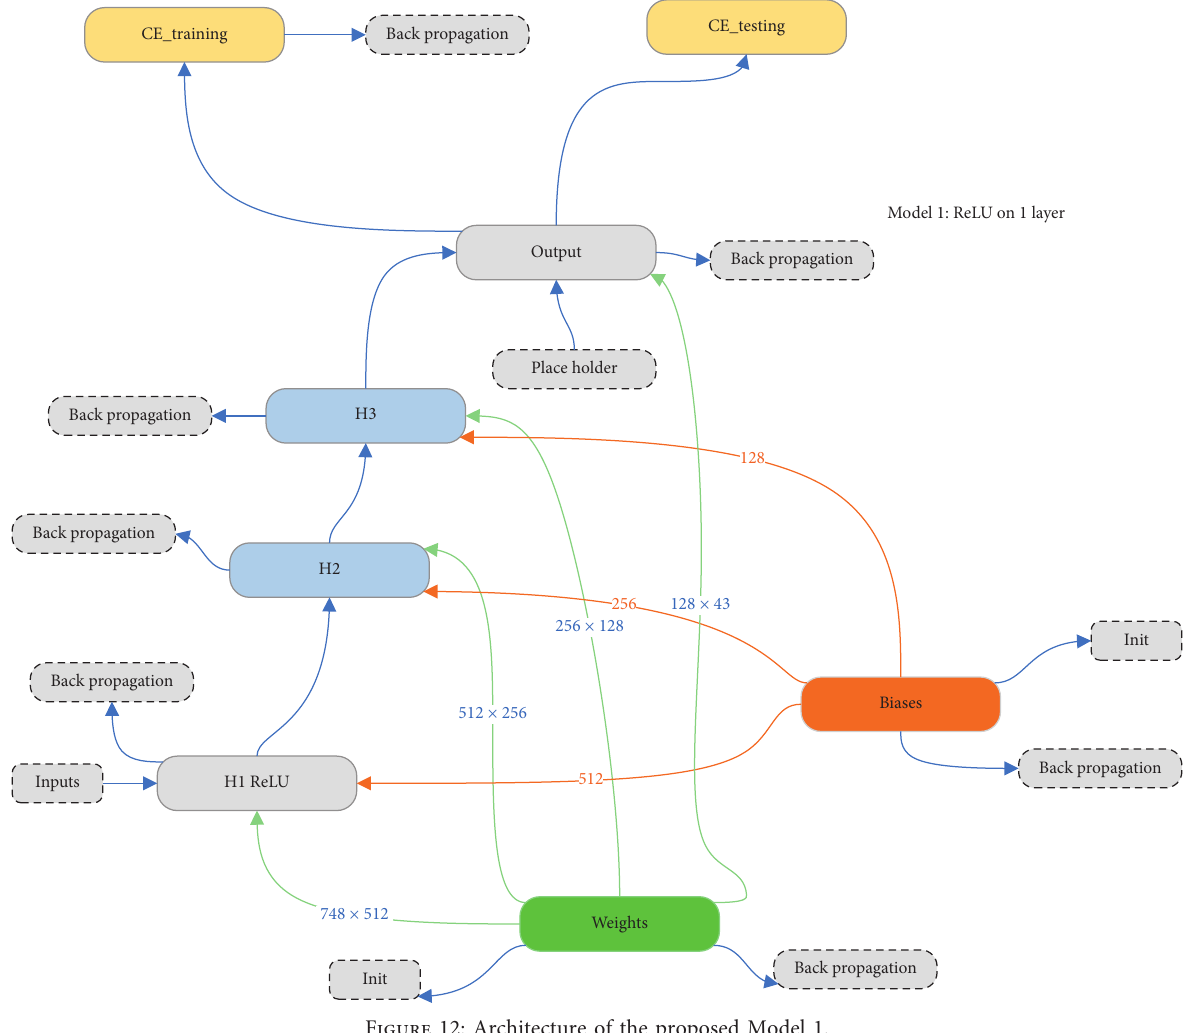
Figure 12: Architecture of the proposed Model 1.